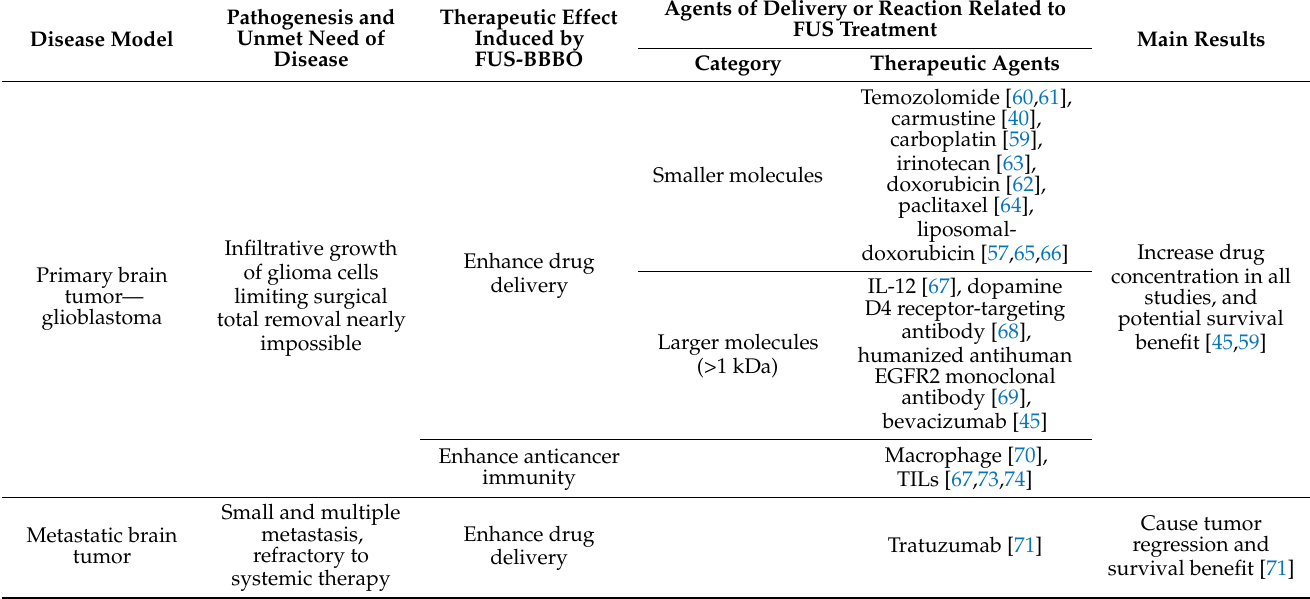
Table 1. Summary of preclinical experimental results of different mechanisms of FUS-BBBO in various disease models.